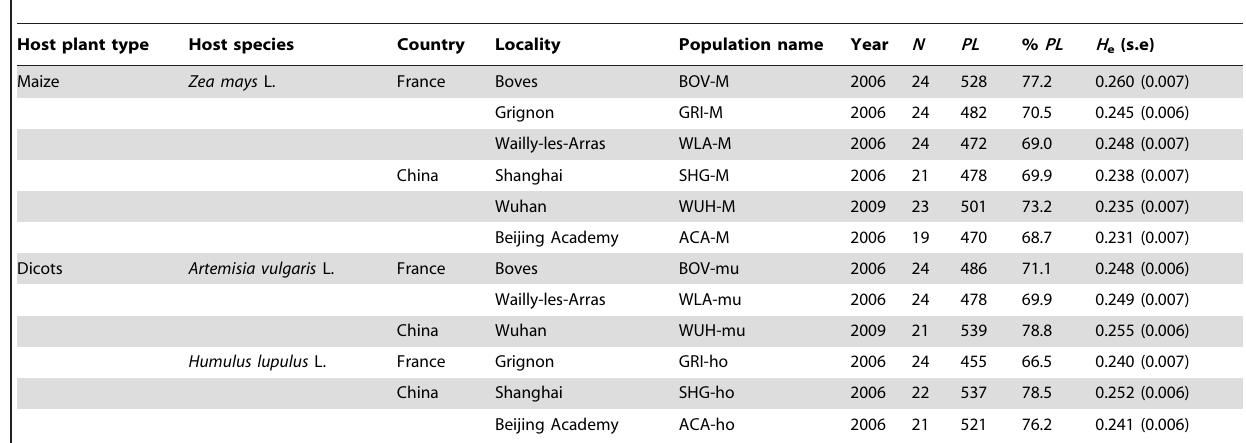
Table 1. Details on the Ostrinia spp. samples collected on maize and dicots in France and China.